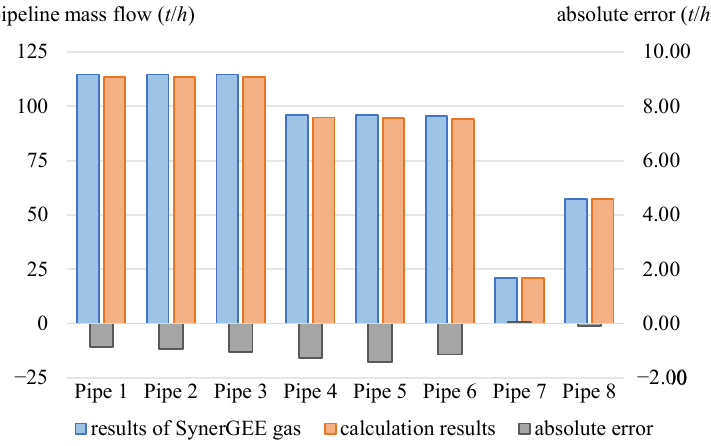
Figure 12. Results of the pipeline flow calculation.